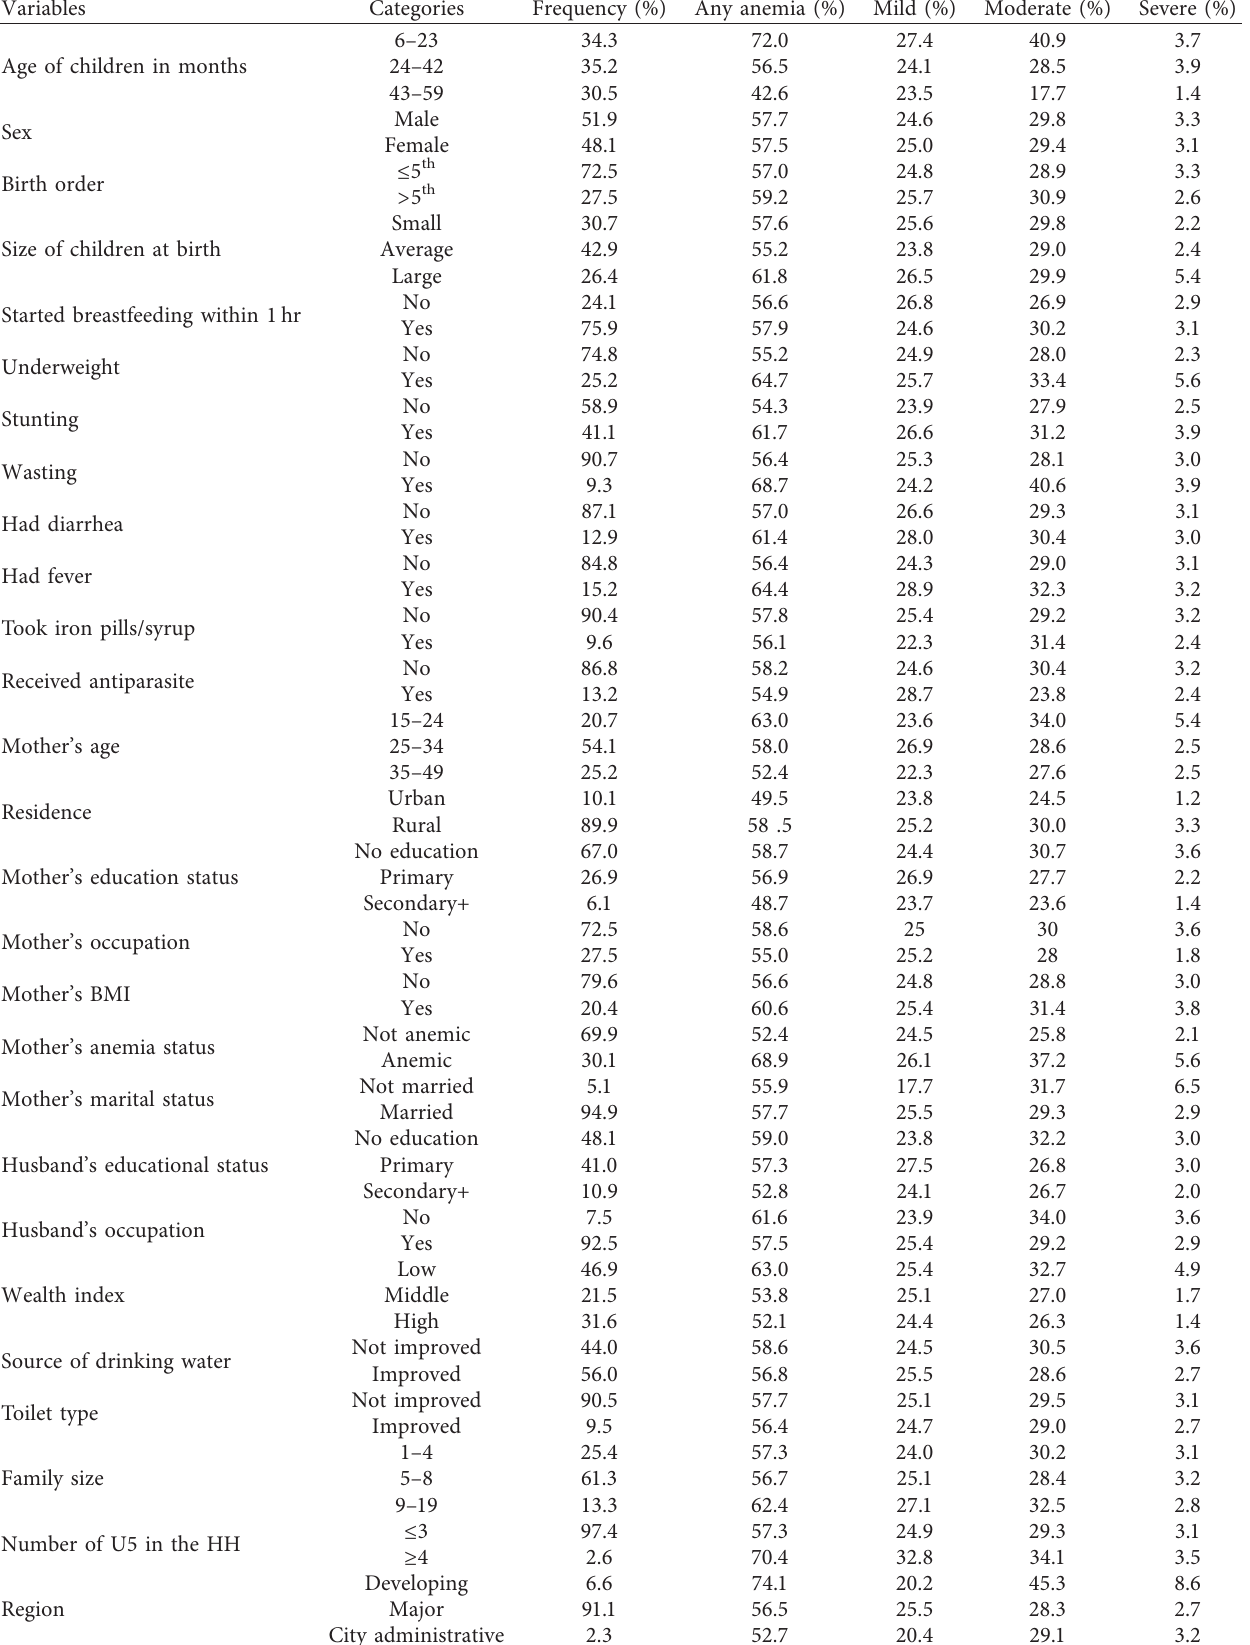
Table 1: Sociodemographic characteristics of children and their mothers and prevalence of anemia among children aged 6–59 months in Ethiopia, 2016